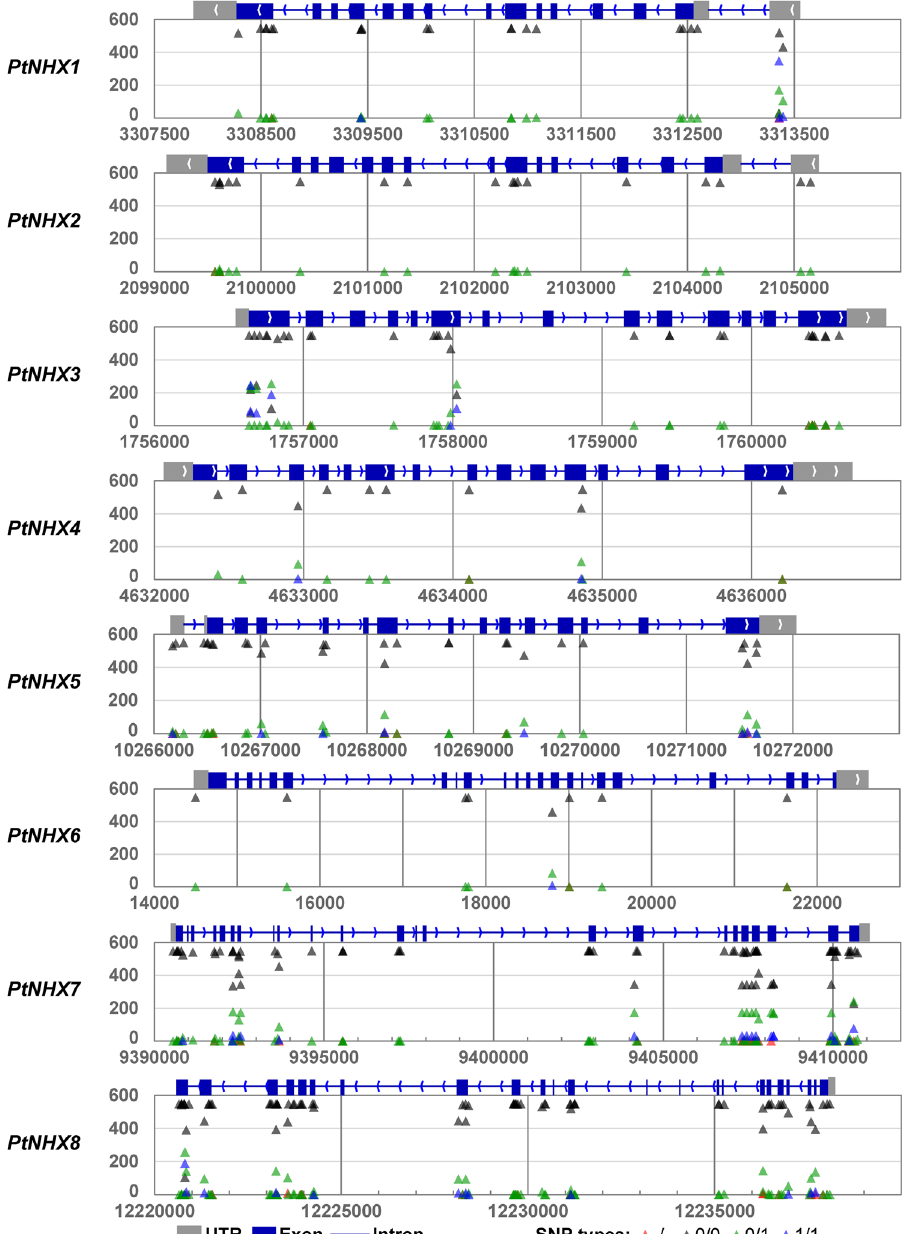
Figure 9. Identification of SNPs in PtNHX gene family from 549 P. trichocarpa